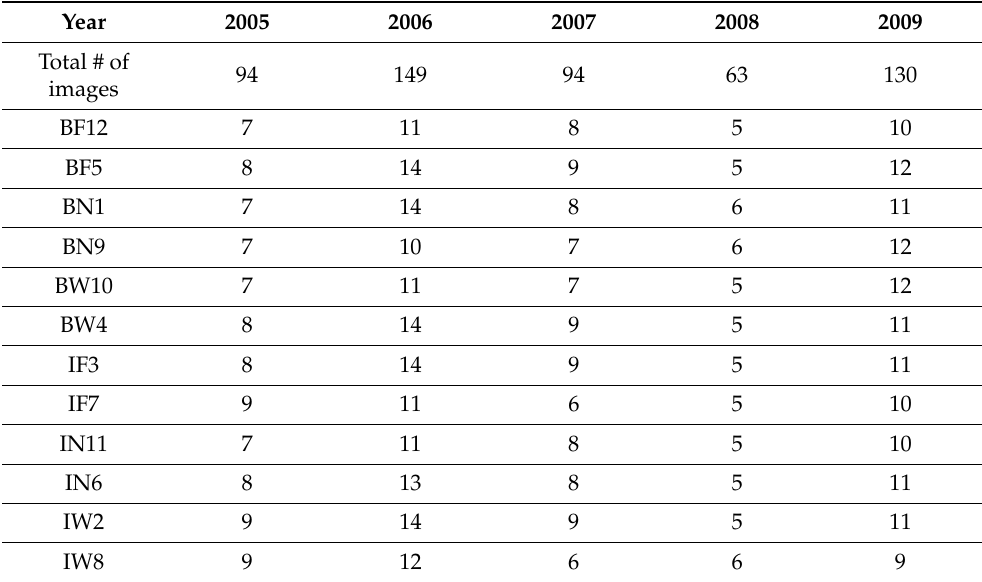
Table 2. Total number of images collected for every paddock during each year. B: Broiler litter;